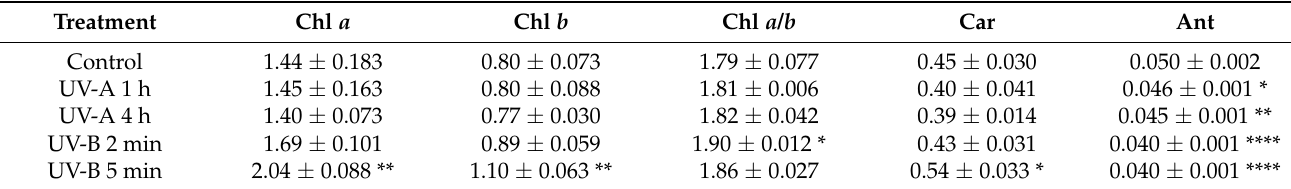
Table 2. Pigment contents in leaves from plants exposed for 30 d to different UV-A/B conditions and control. Chlorophyll a and b (Chl a and Chl b) (mg g − 1 FM), chlorophyll ratio a/b (Chl a/Chl b), carotenoids (car) (mg g(FM) − 1 ) and anthocyanins (ant) ( µ mol g(FM) − 1 ) values. Within each parameter, *, **, and **** represent significant differences for p < 0.05, 0.01, and 0.0001, respectively. Values are expressed as the mean and standard deviation (n = 10).